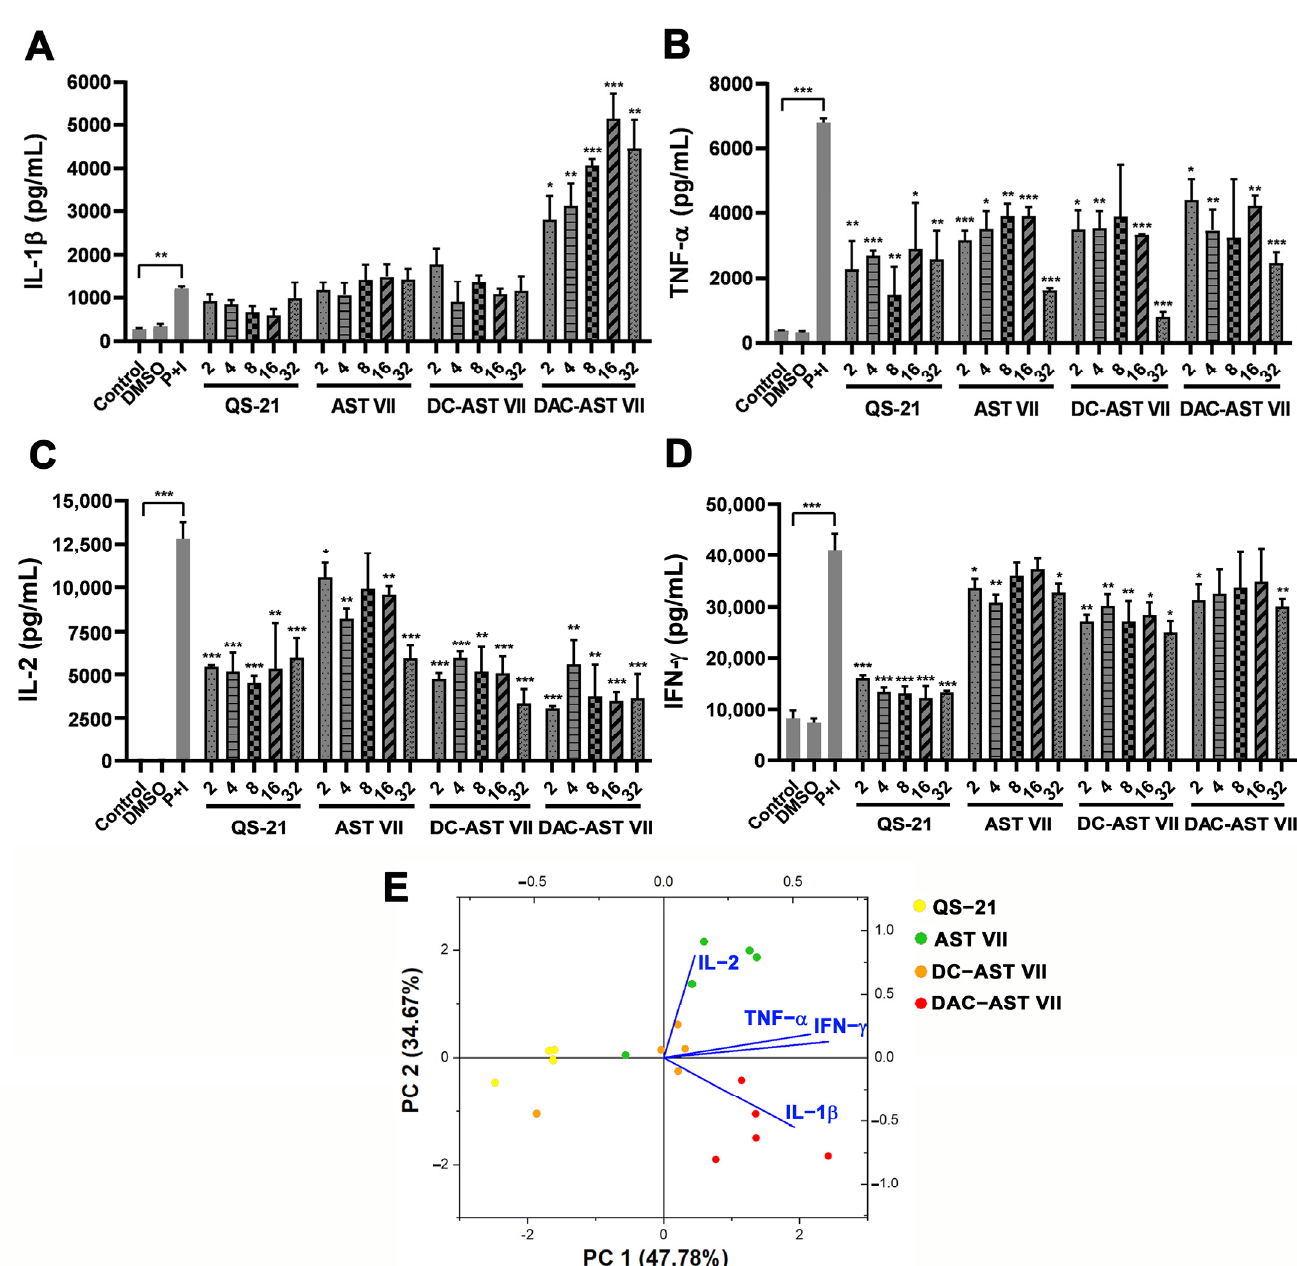
Figure 2. AST VII and its derivatives (DC-AST VII and DAC-AST VII) alter the production of pro- inflammatory and Th- mediated cytokines in hWB cells. Diluted hWB was co-treated with PMA (50 ng/mL)/ionomycin (400 ng/mL) and the following compounds: QS-21, AST VII, DC-AST VII, DAC-AST VII at the concentration of 2–32 µ g/mL for 48 h. The supernatants were collected for the detection of cytokines using ELISA. ( A ) IL-1 β , ( B ) TNF- α , ( C ) IL-2, and ( D ) IFN- γ in 1/20 diluted hWB. ( E ) Principal component analysis (PCA) biplot illustrating the cytokine responses and corresponding compound treatments in hWB. Data are projected onto the plane of the first two principal components (PCs) and colored by the different compounds. DMSO was used as vehicle control. Data shown are mean ± SD of triplicate determinations and representative of two independent experiments with similar results. Statistical analyses were performed between the control and P+I (PMA+Ionomycin) using Student’s t-test and P+I and treated groups using One-way ANOVA and Tukey’s multiple comparison tests. * p < 0.05, ** p < 0.01, *** p < 0.001, not statistically significant